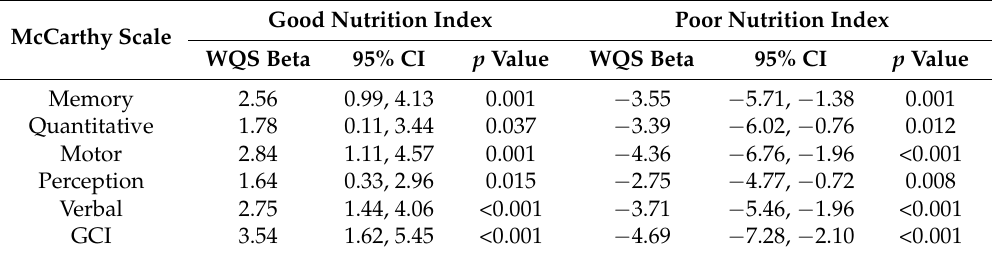
Table 3. Weighted quantile sums (WQS) regression for prenatal “good” and “poor” nutrition indices in relation to child McCarthy Scales scores.